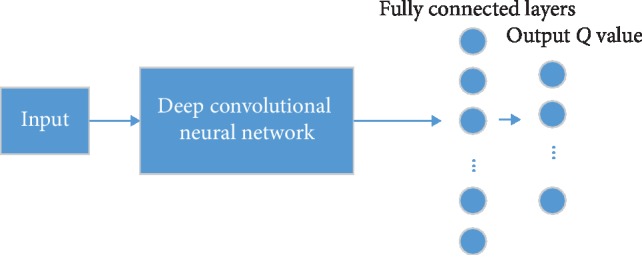
Architecture of DQN.